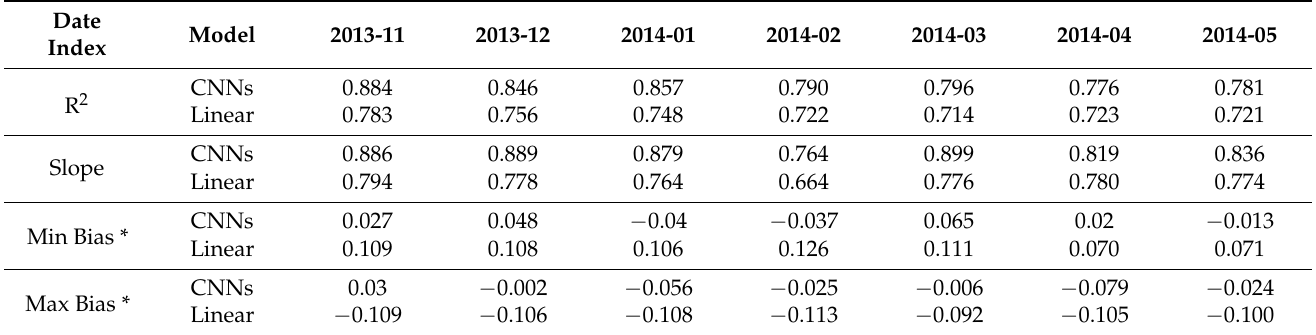
Table 2. Results of leave-one-out cross-validation for CNNs and linear